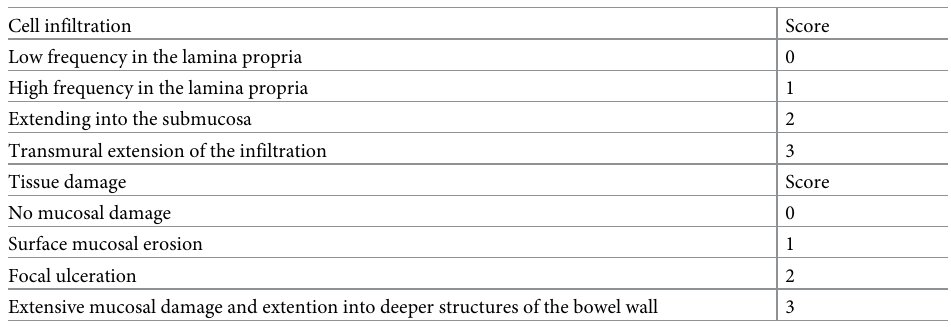
Table 1. Histological